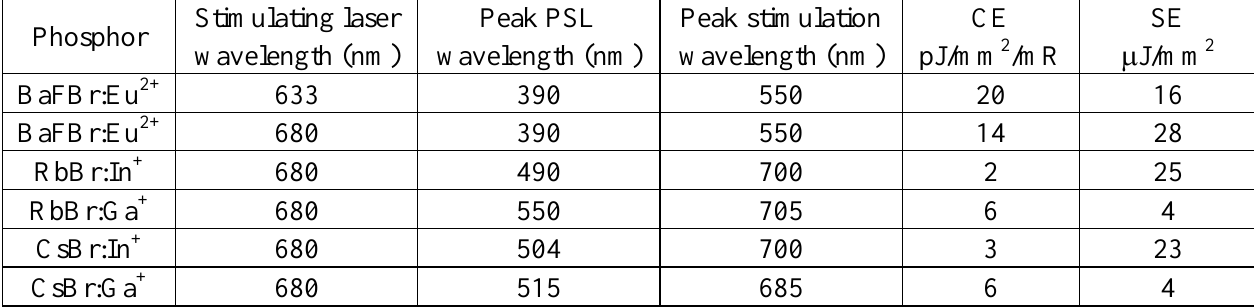
Table 1. PSL characteristics of In + and Ga + doped alkali halide storage phosphors in comparison with standard BaFBr:Eu 2+